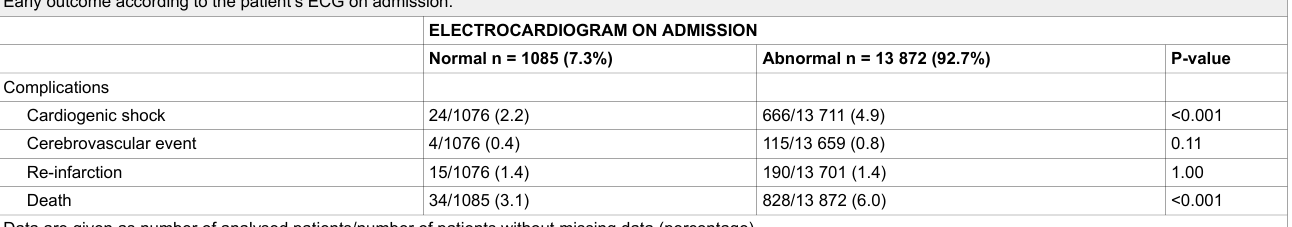
Data are given as number of analysed patients/number of patients without missing data